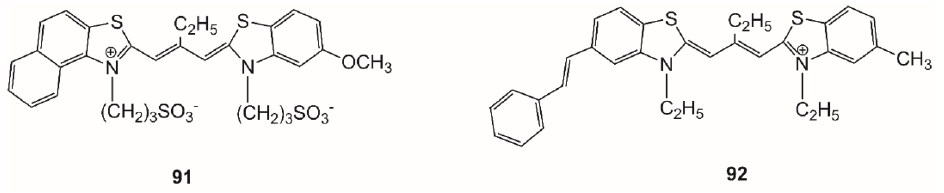
Figure 19. Structures of unsymmetrical meso ‐ substituted trimethine cyanines 91, 92